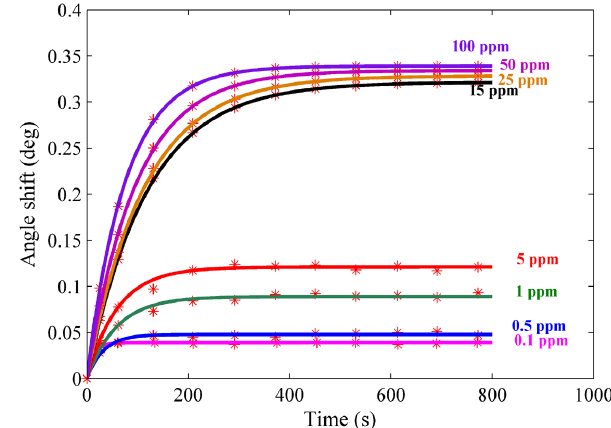
Figure 9. Sensogram for different concentration of the Fe ion detected using